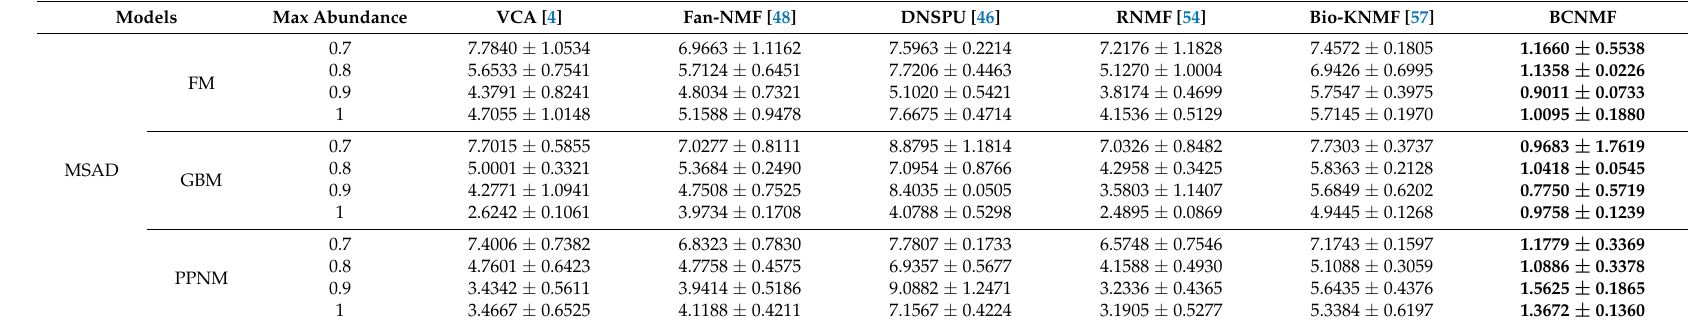
Table 8. MSADs of all algorithms with different degrees of mixing.